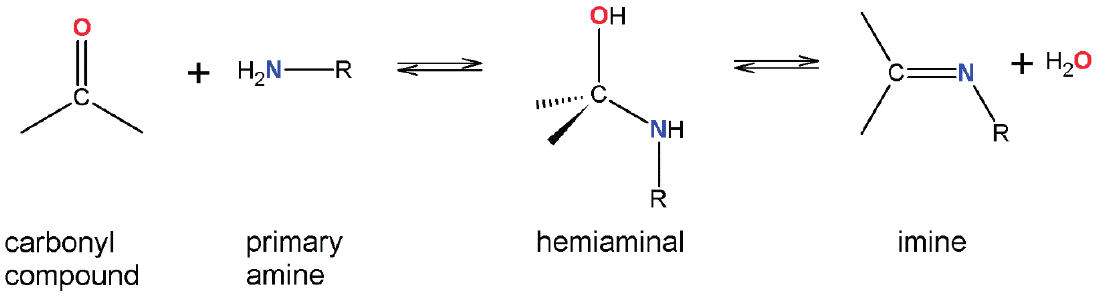
Scheme 1. Reaction scheme between carbonyl compounds and primary amines.